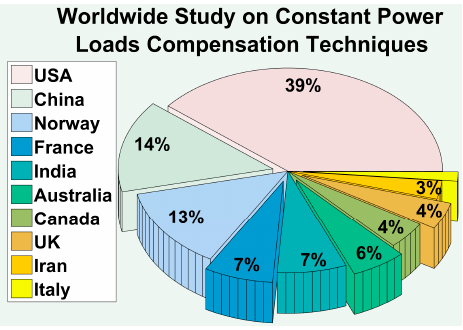
Figure 3. Contributions of different countries on Constant Power Load Instability Compensation research.